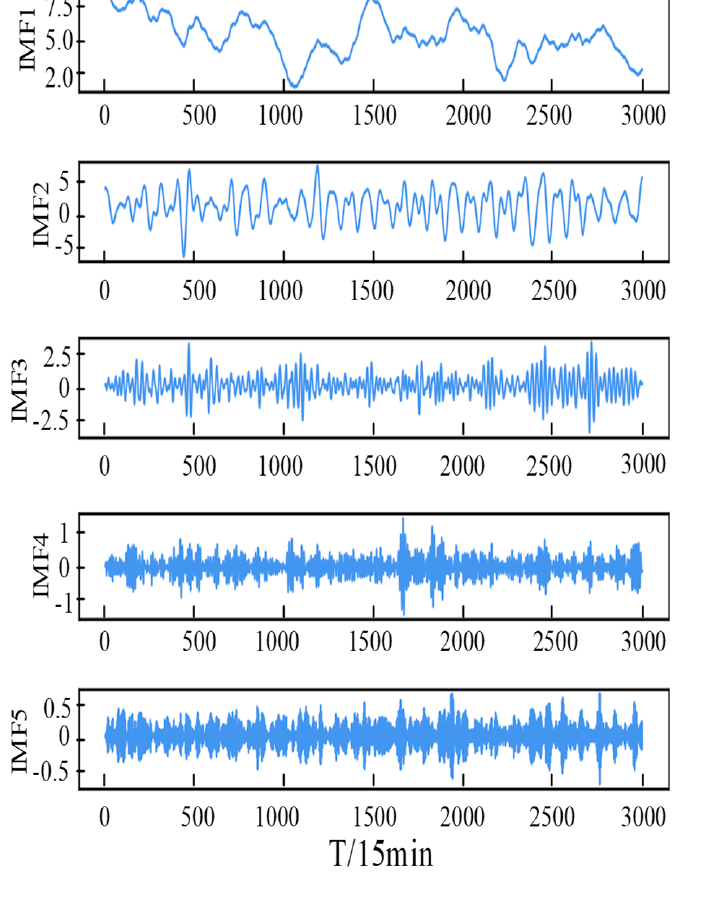
Figure 5. Decomposed sub–sequence of wind speed by VMD.